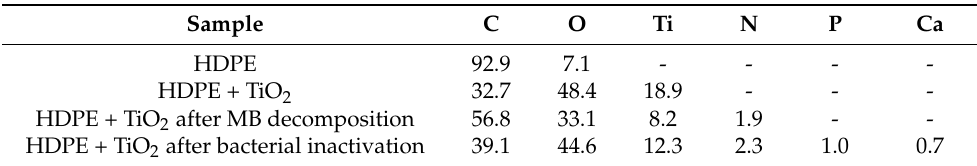
Table 1. XPS surface elemental composition, atom%.